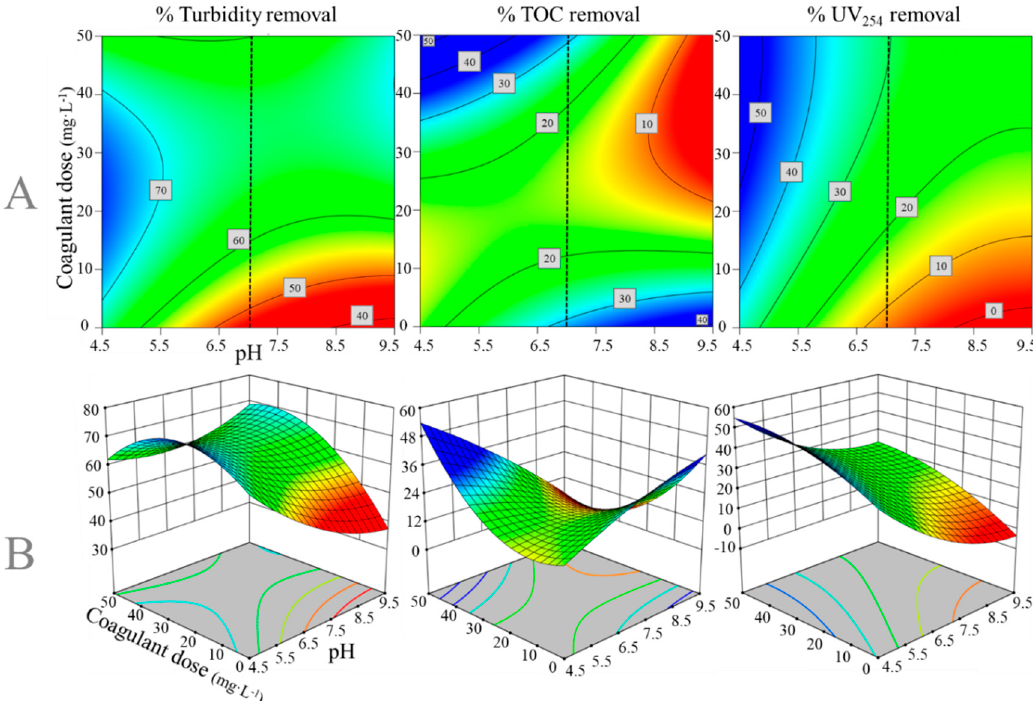
Figure 5. ( A ) Two-dimensional (2D) response surface plots and ( B ) three-dimensional (3D) response surface plots of turbidity, total organic carbon (TOC), and UV 254 removal for the model factors, coagulant dose and pH. Dotted line in 5A corresponds to pH = 7.